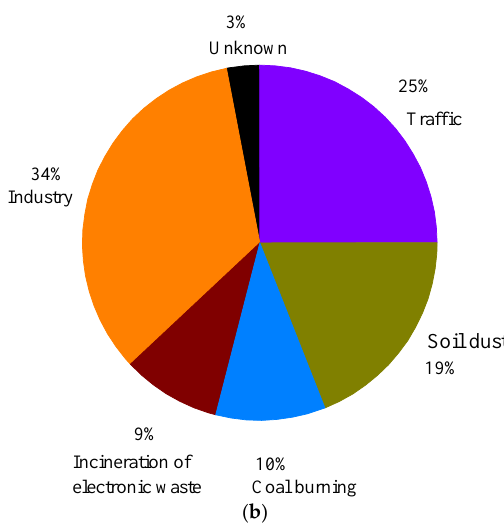
Figure 6. ( a ) Source contributions deduced from the PMF analysis of PM 2.5 ; ( b ) Pie of the contributions.